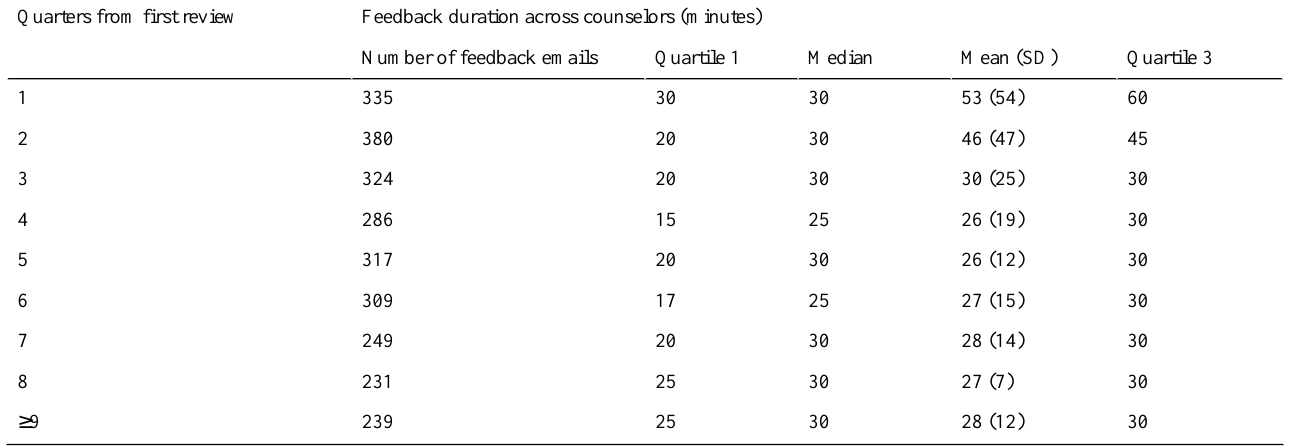
Table 1. Change in feedback durations across counselors.